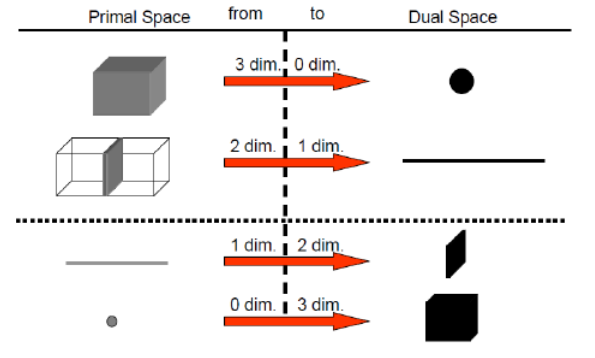
Figure 4. Poincaré Duality (Lee, J. 2004)